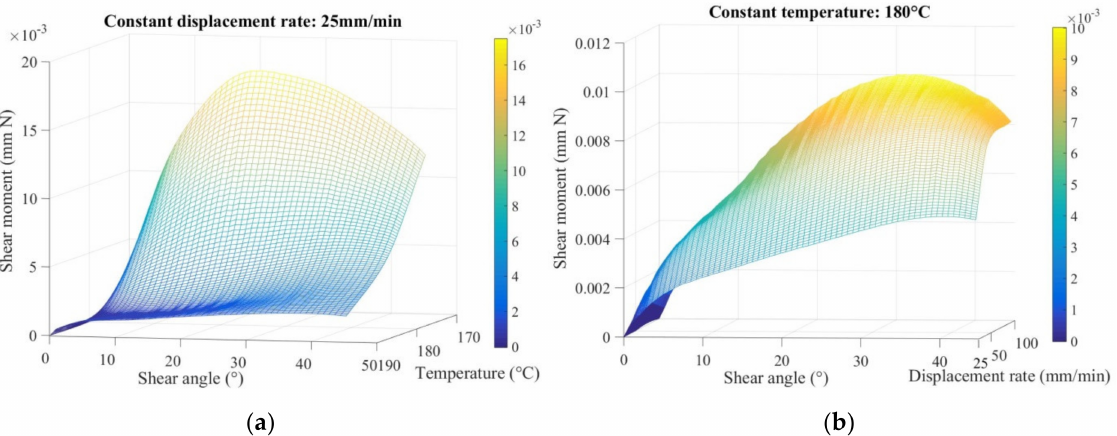
Figure 10. Shear moment versus shear angle meshes of BR-B-AD at different thermo-conditions: ( a ) temperature-dependent experiments and ( b ) displacement rate-dependent